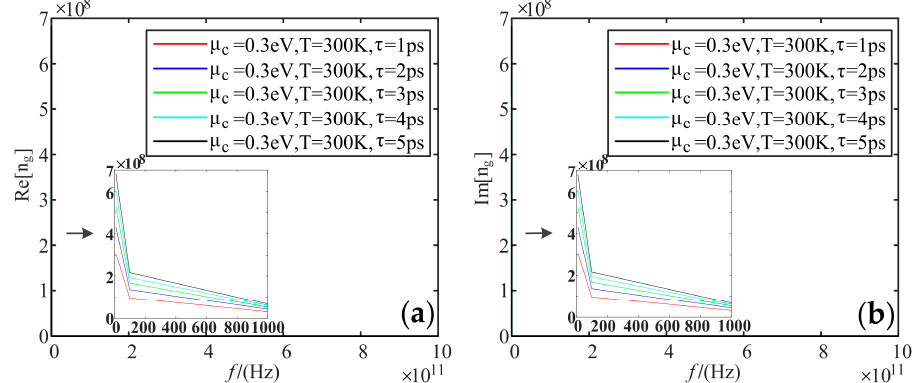
Figure 12. Variation curve of the refractive index of graphene with frequency at different relaxation times: ( a ) real part; ( b ) imaginary part.